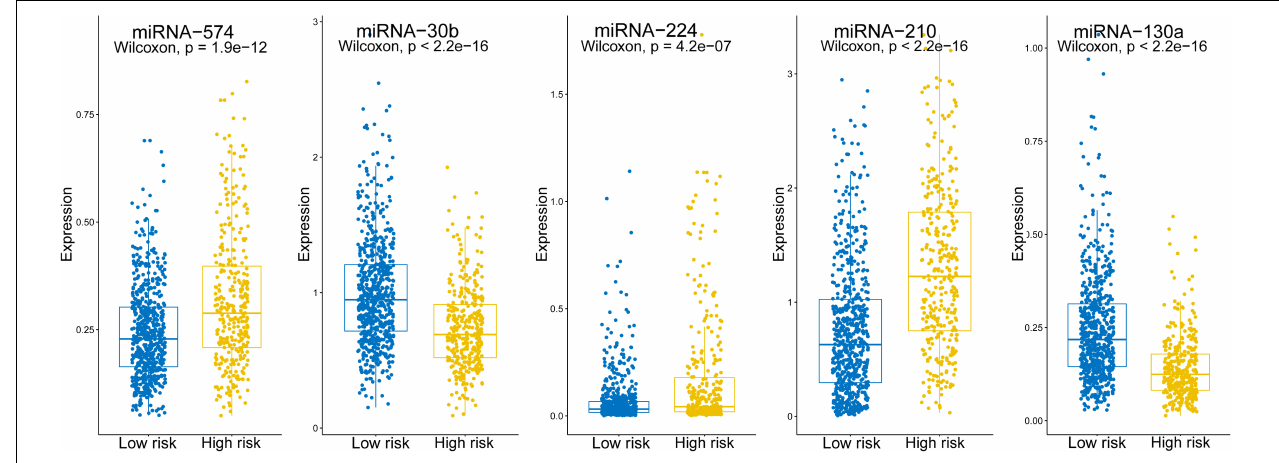
FIGURE 2 | Expression levels of the five screened miRNAs. Boxplots show the expression levels of the five miRNAs in the high- and low-risk groups.